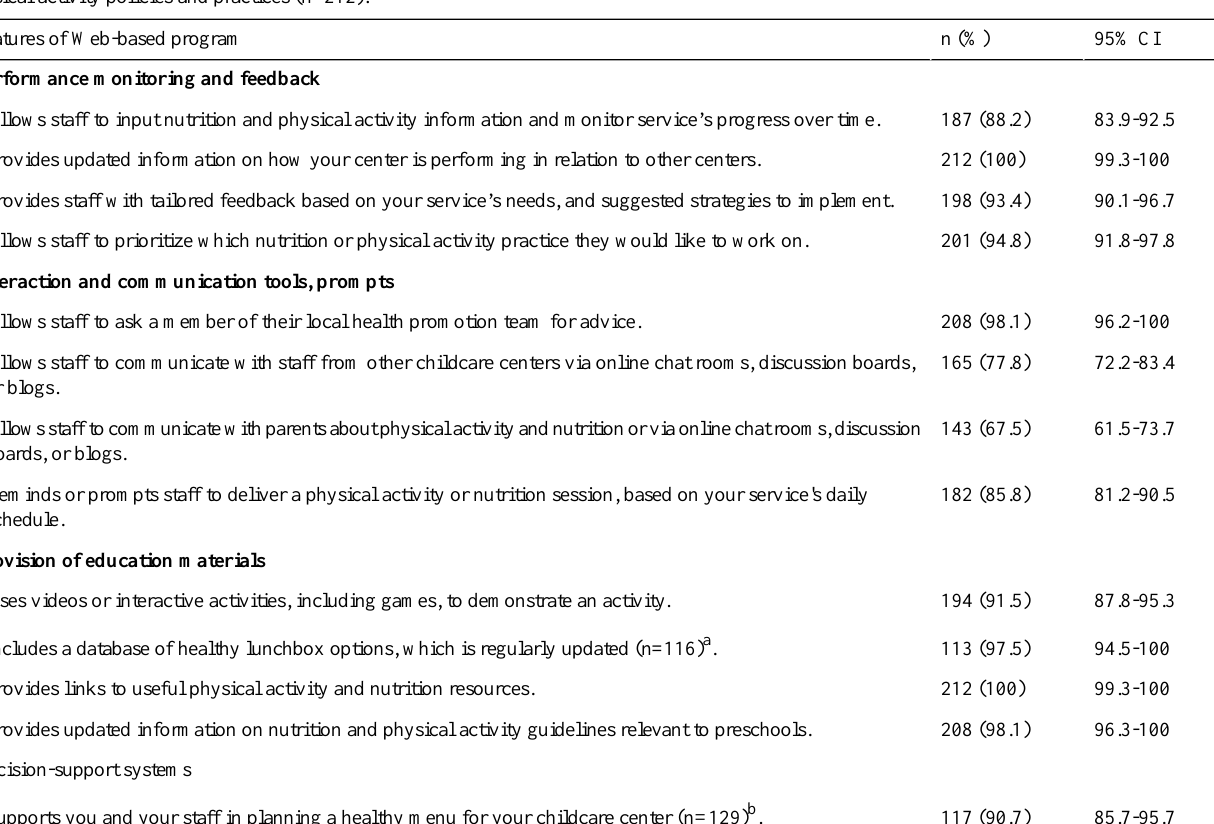
Table 4. Features of a Web-based program reported by service managers as useful or very useful to help their staff implement healthy eating and physical activity policies and practices